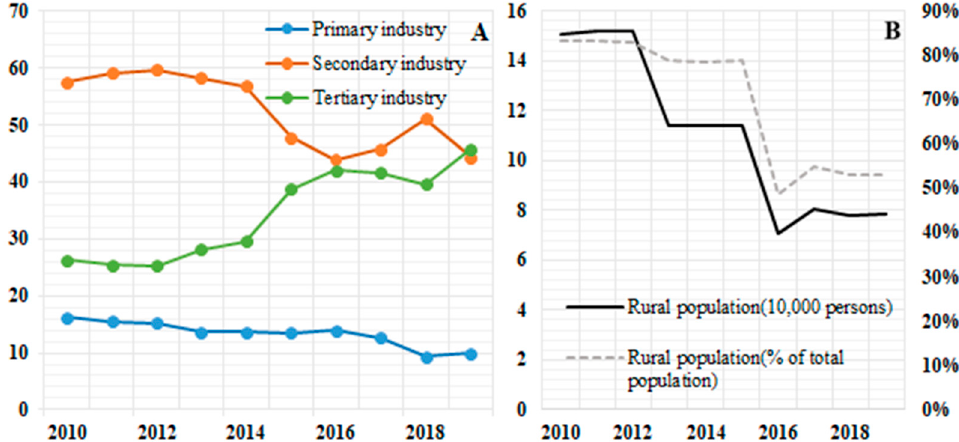
Figure 2. Changes in the industrial structure of Gaolan county from 2010 to 2019 ( A ); Rural population and percentage of the total population over the same period ( B ).